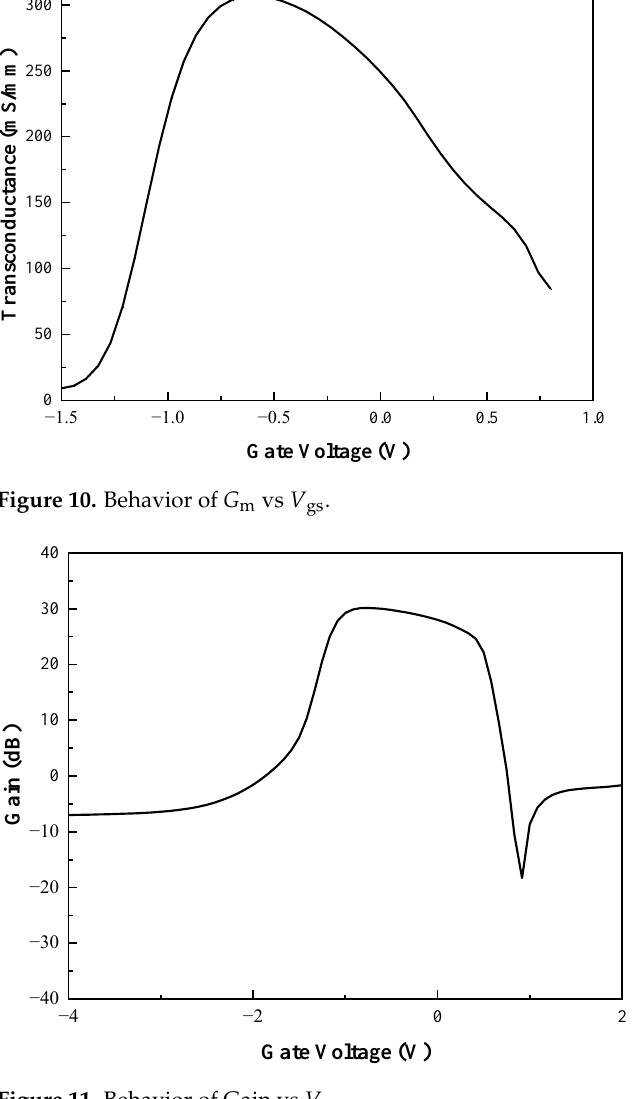
Figure 11. Behavior of Gain vs V gs .